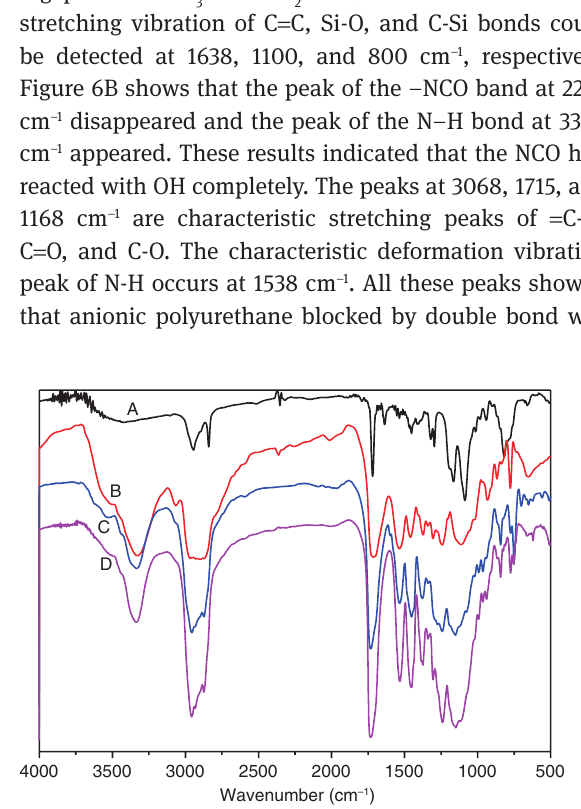
Figure 7: FTIR spectra of SPUA0 (A), SPUA2 (B), SPUA4 (C), and SPUA6